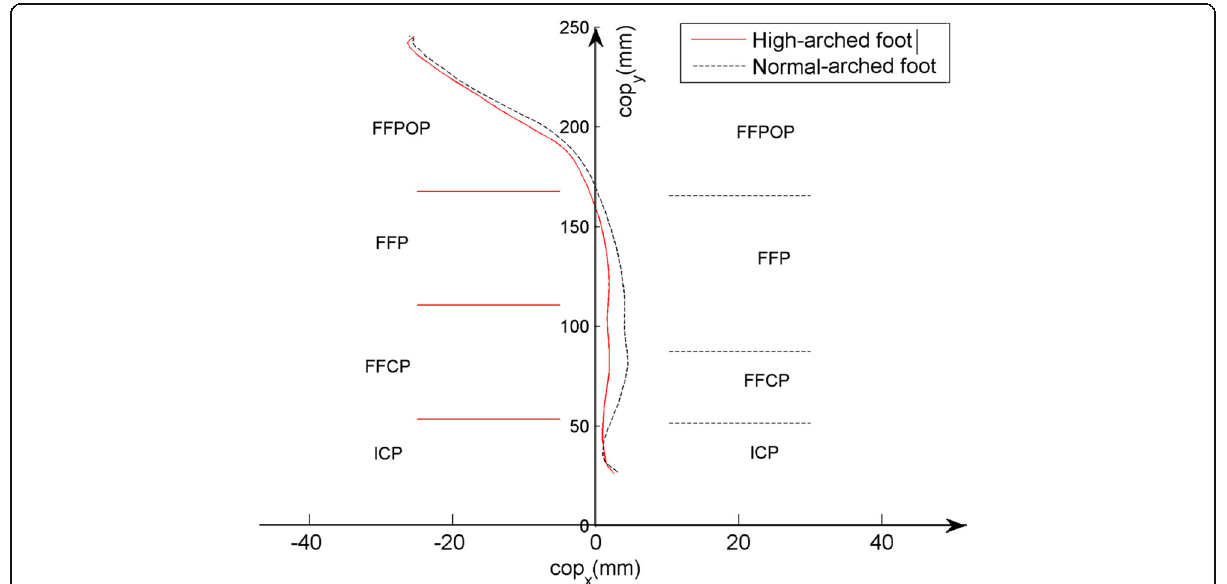
Fig. 1 The trajectory of COP of high-arched and normal-arched foot. The y-axis is the longitudinal axis of the foot, and x-axis is perpendicular to the longitudinal foot axis. Sub-classified phases are ICP, FFCP, FFP and